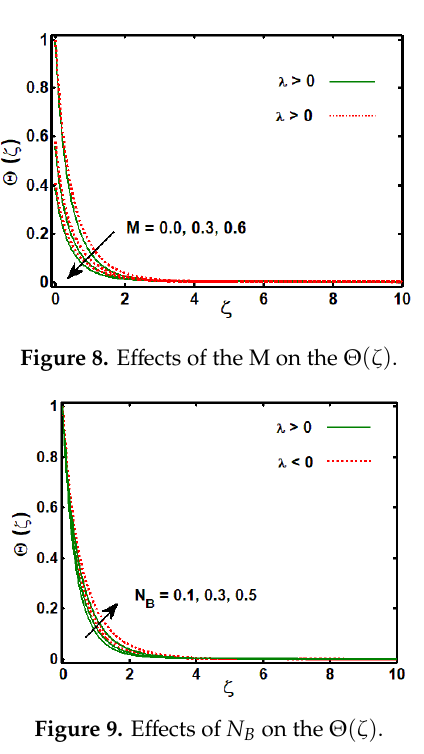
Figure 9. Effects of 𝑵 𝑩 on the 𝜣(𝜻) .